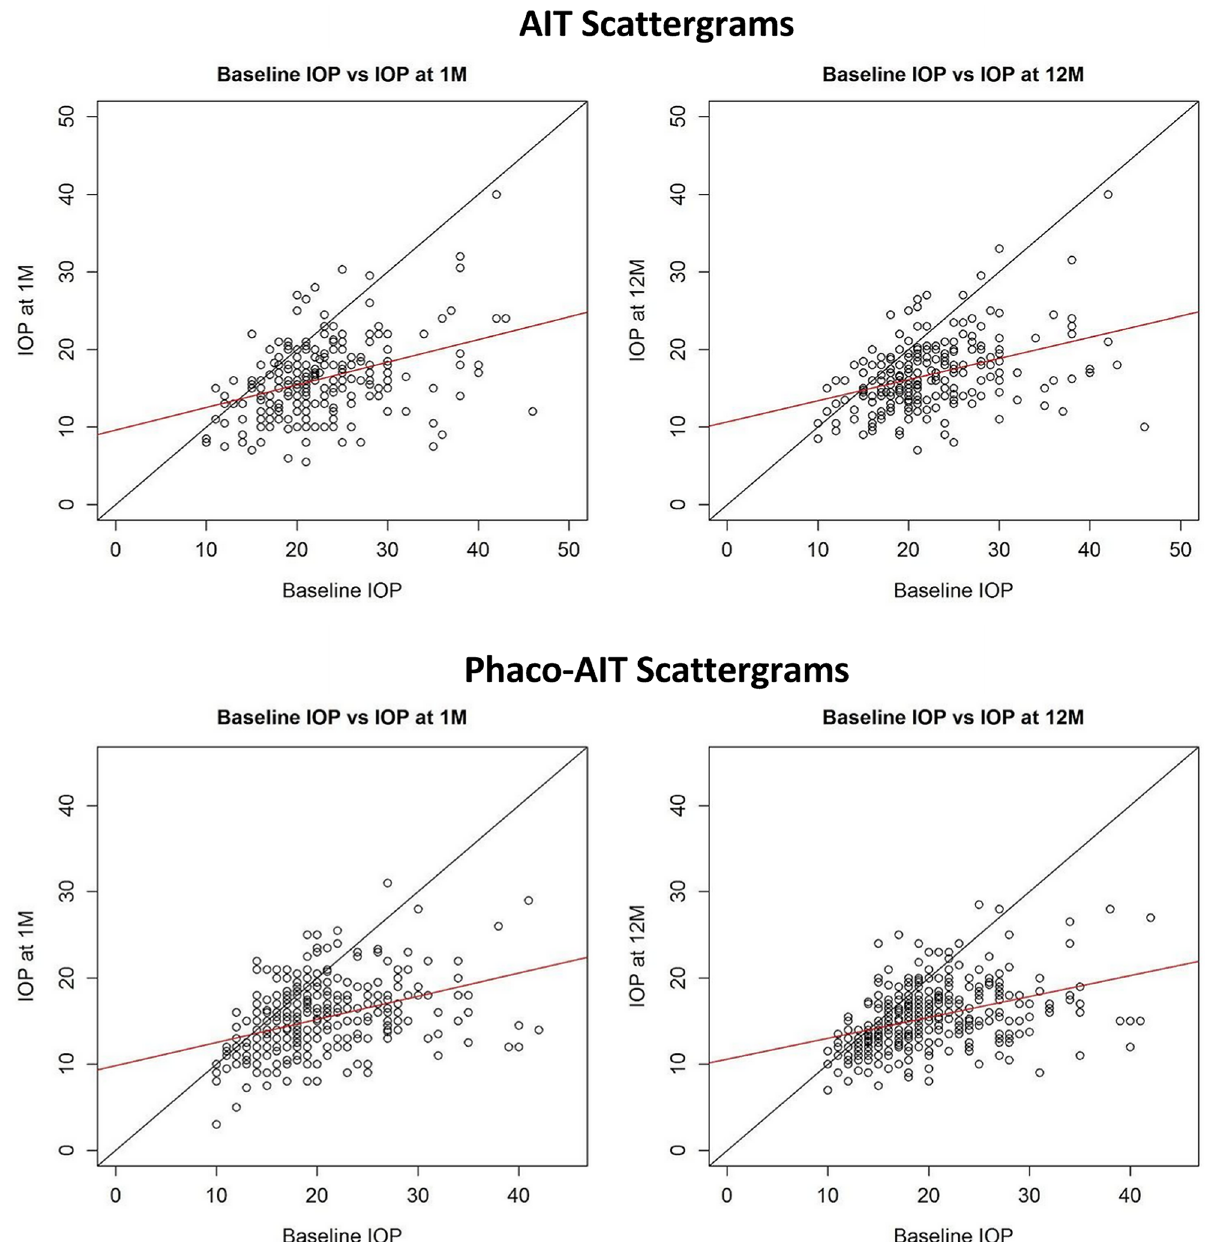
Fig 3. Phaco-AIT and AIT Scattergrams. Scattergrams of AIT and phaco-AIT after 1 month (left) and 12 months (right). Baseline IOP plotted against IOP at 1 month and 12 months with x = y line. Red line represents linear fit.